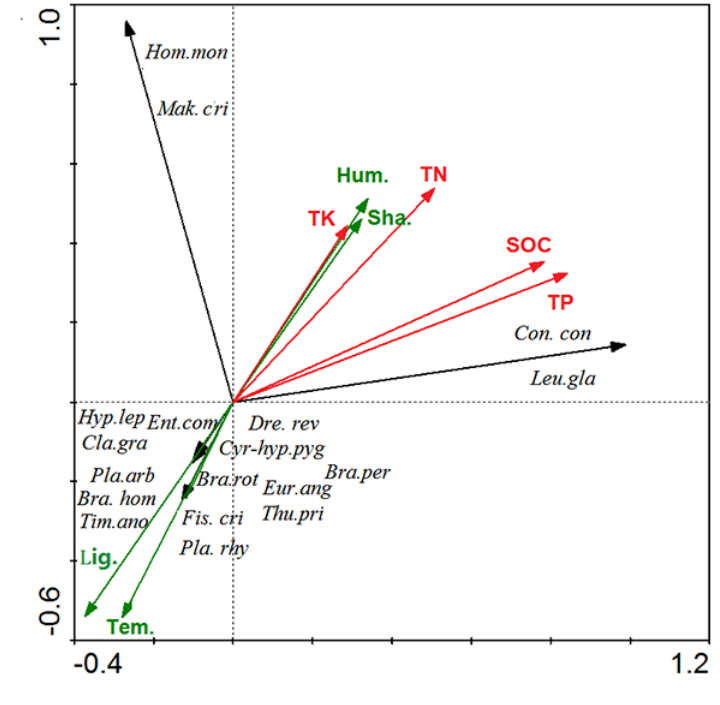
Figure 7 Redundancy analysis (RDA), two-dimensional ordination diagram of species, environmental factors, and soil factors. The green solid arrow represents the environmental factors variable, the red solid arrow represents the soil factors variable, and the black solid arrow represents the number of species in the sequencing diagram. The angle between the arrows represents the correlation between variables, and the angle cosine represents the correlation coefficient between the two variables.